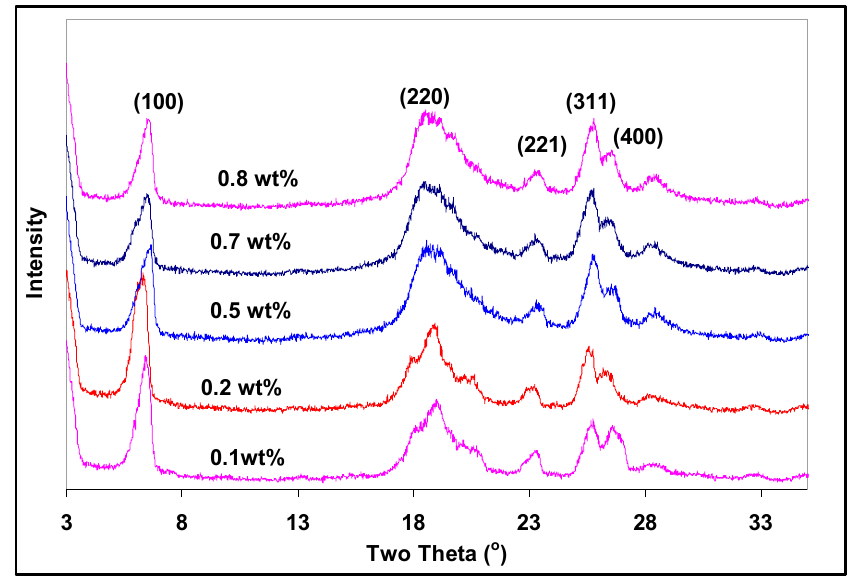
Figure 7. WAXD pattern for PANi, PACN, and Cloisite 20 A clay, showing the crystalline peak for PANi and the disappearance of d 001 peak in the PACN diffractograph for the 2 θ ° angle range tested.